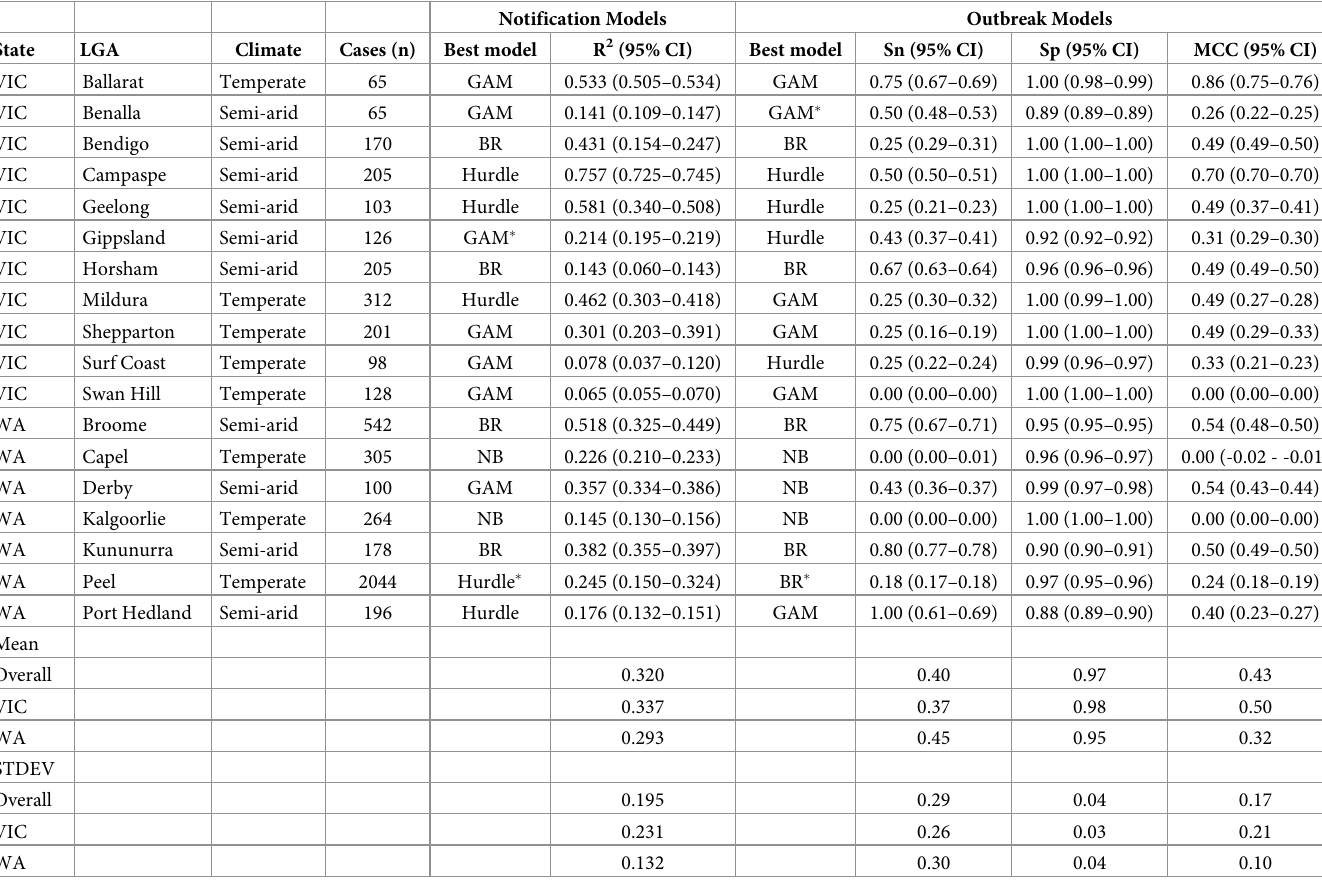
Table 1. Best fit model predictive performance of RRV notifications and outbreaks in local government areas (LGA) in Victoria (VIC), and Western Australia (WA) by LGA climate. The total number of RRV notifications (Cases), the best model used for predicting RRV notifications, adjusted R-squared coefficient (R 2 ), the best model used for predicting outbreaks, sensitivity (Sn), specificity (Sp), and Matthews correlation coefficient (MCC). ARIMA = auto-regressive integrated moving average model; GAM = generalised additive model; BR = generalised boosted regression; NB = negative binomial regression; and Hurdle = hurdle regression. Ninety five percent confidence intervals (95% CI) are given of the distribution of each predictive performance measure from Jackknife pseudo-random sampling using the respective best fit model. Models with a “ � ” following the model type used the Factorial Approach. See Table 2 for a comparison of how close modelling methods were to one another for pre- dicting RRV notifications and